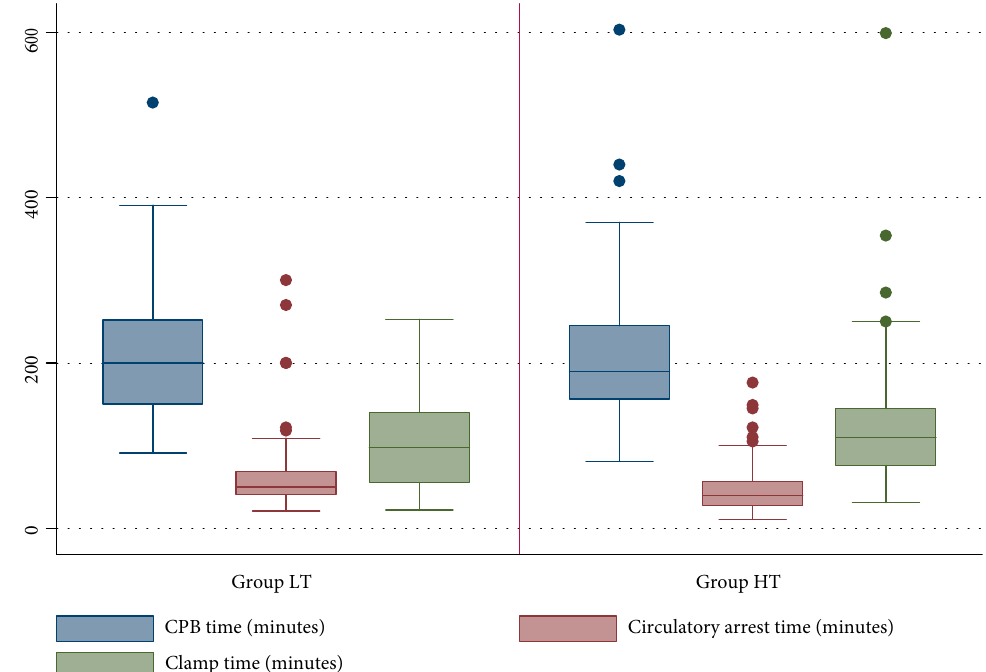
Figure 2: Box plot showing distribution of intraoperatory times over our population. Group LT: Arrest circulation temperature <24°C;